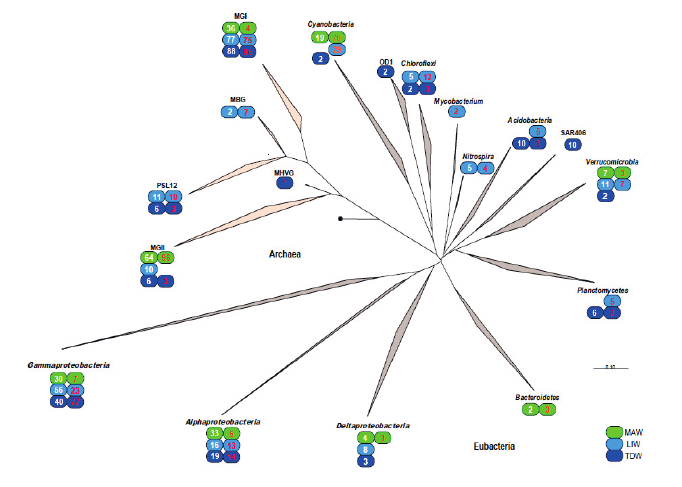
Figure 2. Phylogenetic affiliation and relative abundance of archaeal and bacterial clones from the Station Vector water column classified at the class/phylum level. The numbers below each class/phylum represent the percentages of each phylogenetic group detected in either 16S rDNA (white numbers) or 16S rRNA (red numbers) clone libraries obtained from three depths: MAW (green), LIW (blue) and TDW (dark blue). The scale bar represents the expected numbers of changes per nucleotide position. Abbreviations used: OD1 (candidate division OD1); MGI (Marine Group I); MBG (Marine Benthic Group); MGII (Marine Group II); MHVG (Marine Hydrothermal Vent